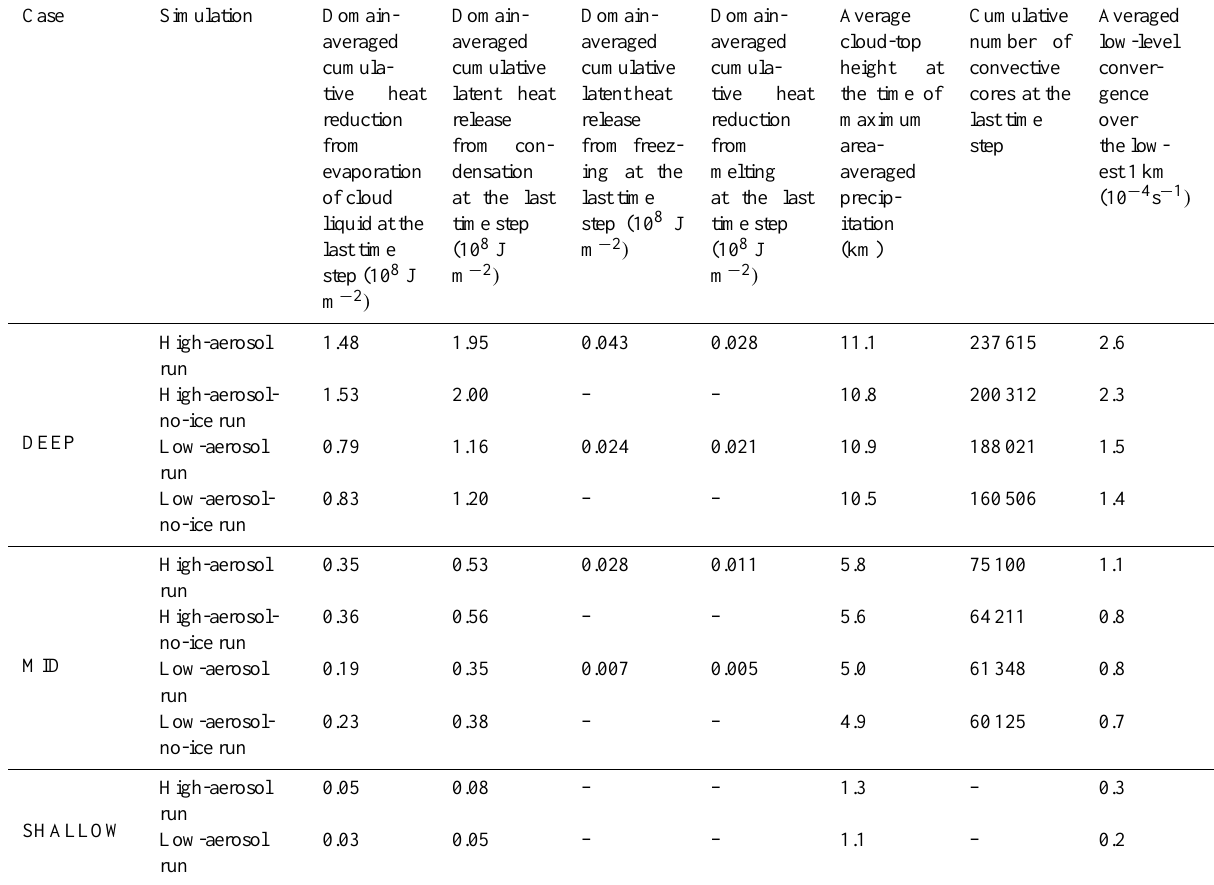
Table 2. Terms of the latent heat absorption and release and terms characterizing the cloud type and gustiness.